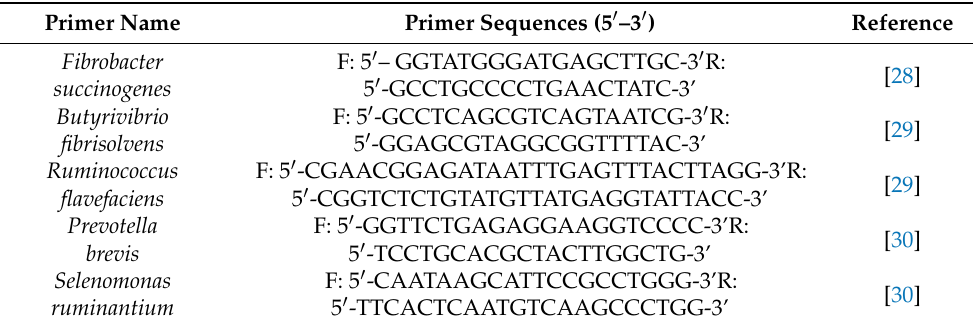
Table 3. The sequence of primers used to determine the relative abundance of